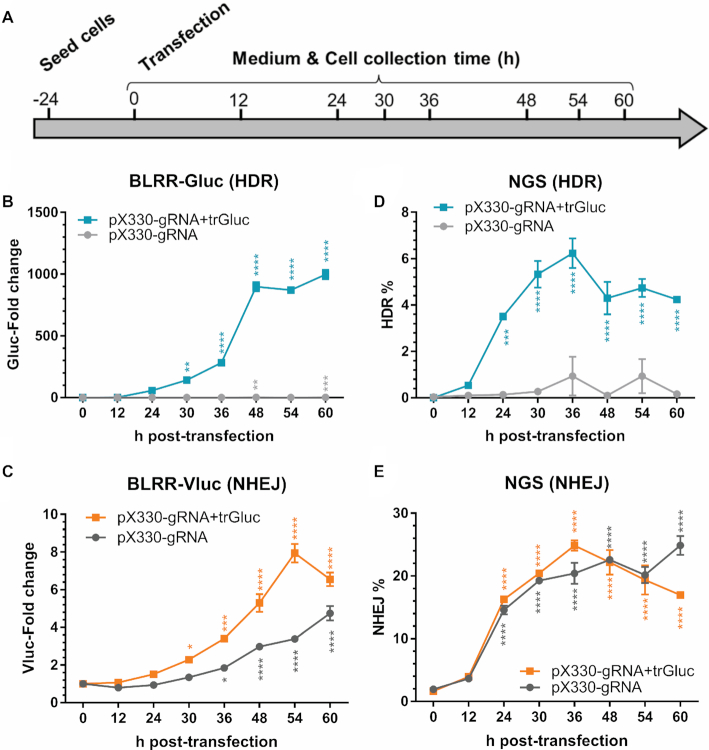
BLRR enables longitudinal tracking of HDR and NHEJ events. (A) Schematic diagram of longitudinal monitoring of DSB repair events. BLRR cells were transfected with or without trGluc donor template, and cells and media were collected at different time points for BLRR and NGS analyses. (B, C) BLRR longitudinally and simultaneously monitors HDR (B) and NHEJ (C) events. BLRR cells were transfected with either px330-gRNA+trGluc or pX330-gRNA (negative control for HDR), and both Gluc and Vluc signals showed a significant increase at 30 h compared to 0 h post-transfection. BLRR signals are shown as the fold change relative to 0 h (mean ± SEM of three biological replicates). Representative data for three independent experiments are shown. (D, E) NGS analysis of cells from (B, C) showing a similar increasing trend in HDR (D) and NHEJ (E) events, with a significant difference from 24 h post-transfection. Data are presented as mean ± SEM of three biological replicates. Significance was calculated using one-way ANOVA compared with 0 h followed by Tukey's post-hoc test (*P < 0.05, **P < 0.01, ***P < 0.001, ****P < 0.0001).